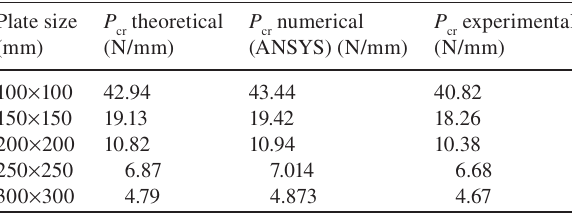
Table 2 Buckling load of 0 ° un-perforated glass-polyester composite plate.